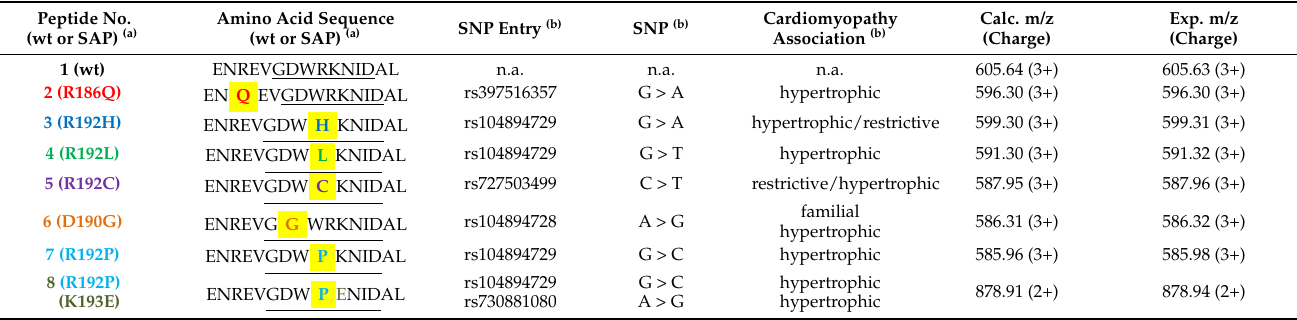
Table 1. Single nucleotide polymorphism information and peptide masses for the anti-hcTn I antibody [MF4]